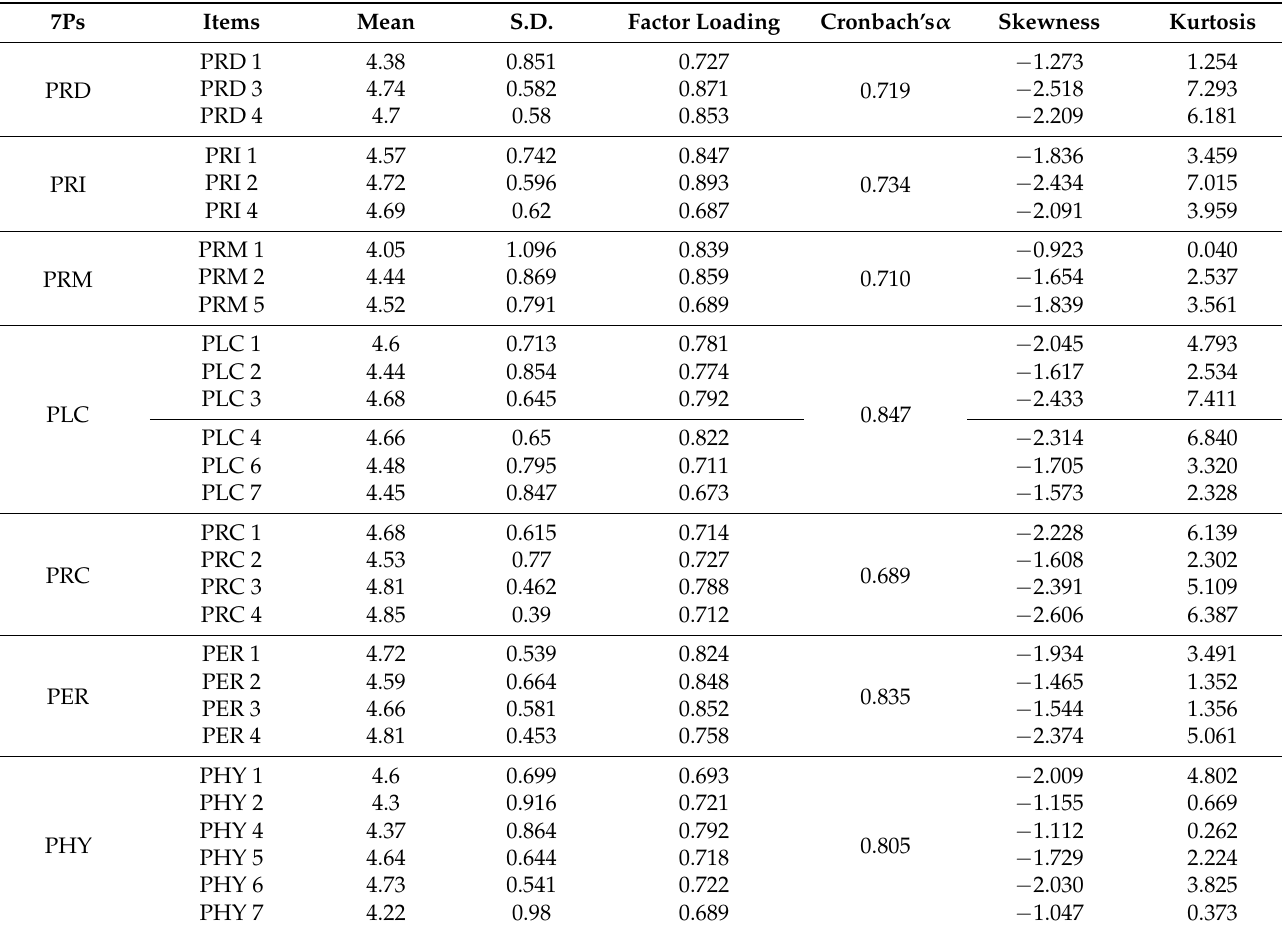
Table A2. Exploratory Factor Analysis Results of